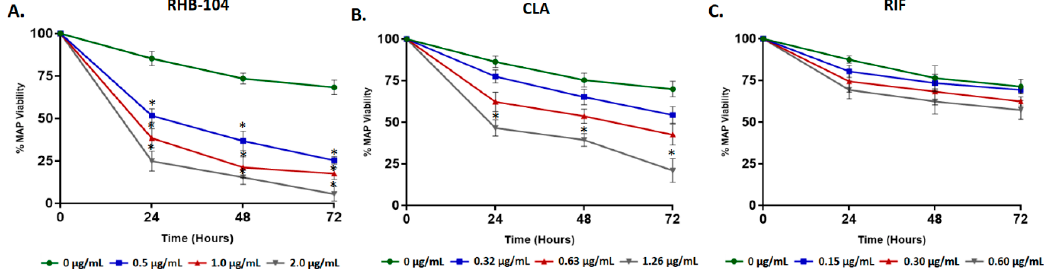
Figure 1. Effect of representative of anti-MAP therapy (RHB-104) and its major components on Mycobacterium avium subspecies paratuberculosis (MAP) viability in infected macrophages. MAP viability was measured in infected macrophages following treatment with RHB-104 (0, 0.5, 1.0, 2.0 µ g / mL) ( A ), clarithromycin (CLA) (0, 0.32, 0.63, and 1.26 µ g / mL) ( B ), and rifabutin (RIF) (0, 0.15, 0.30, 0.60 µ g / mL) ( C ). * p < 0.05.